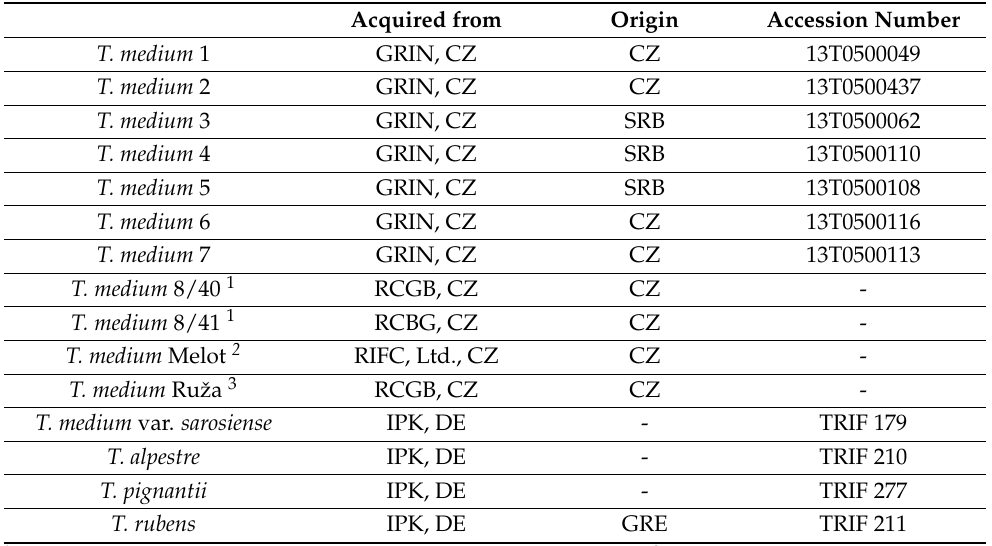
Table 2. Origin and accession numbers of analysed Trifolium species.